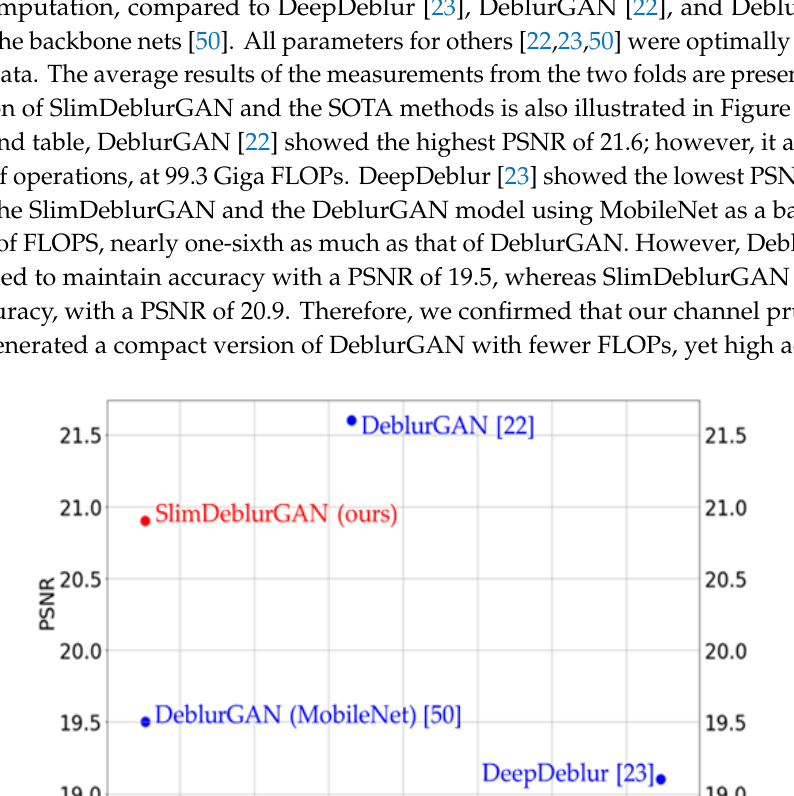
Figure 9. Anchor boxes.